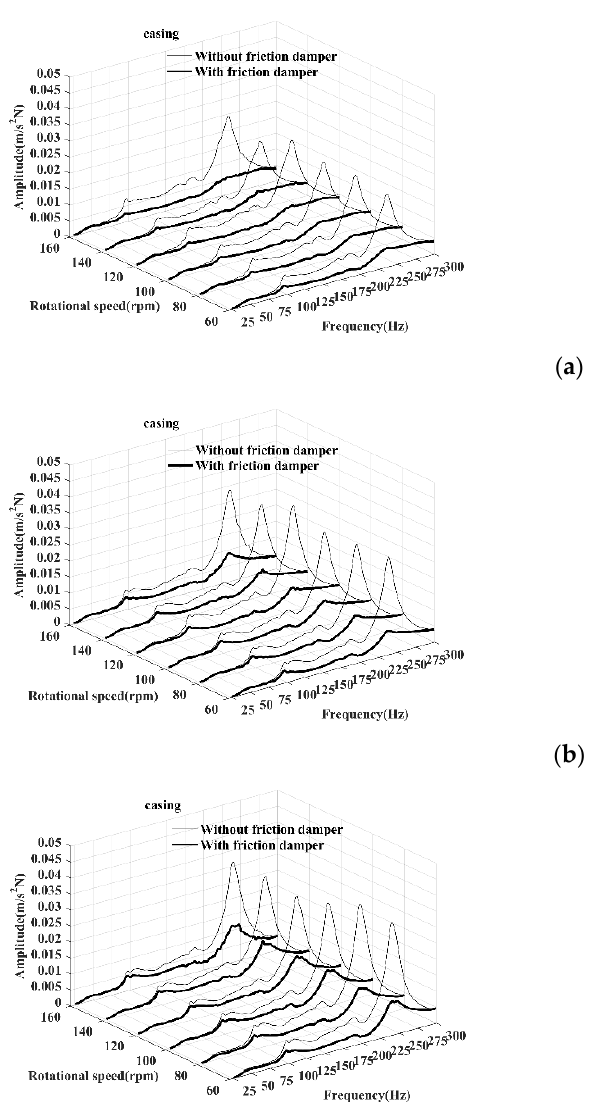
Figure 18. Comparisons of the AFRF of thrust bearing with and without friction damper at differ- ent rotational speeds: ( a ) rotational speed at 60 rpm; ( b ) rotational speed at 160 rpm.